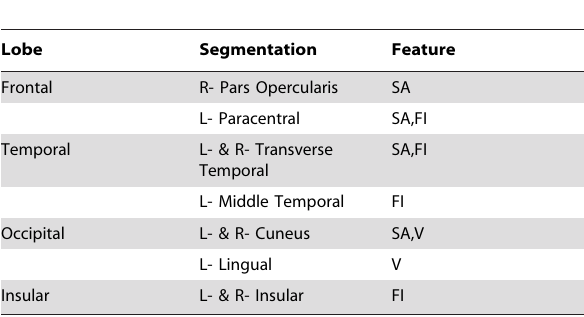
Table 4. Most discriminative brain structure features for ADHD